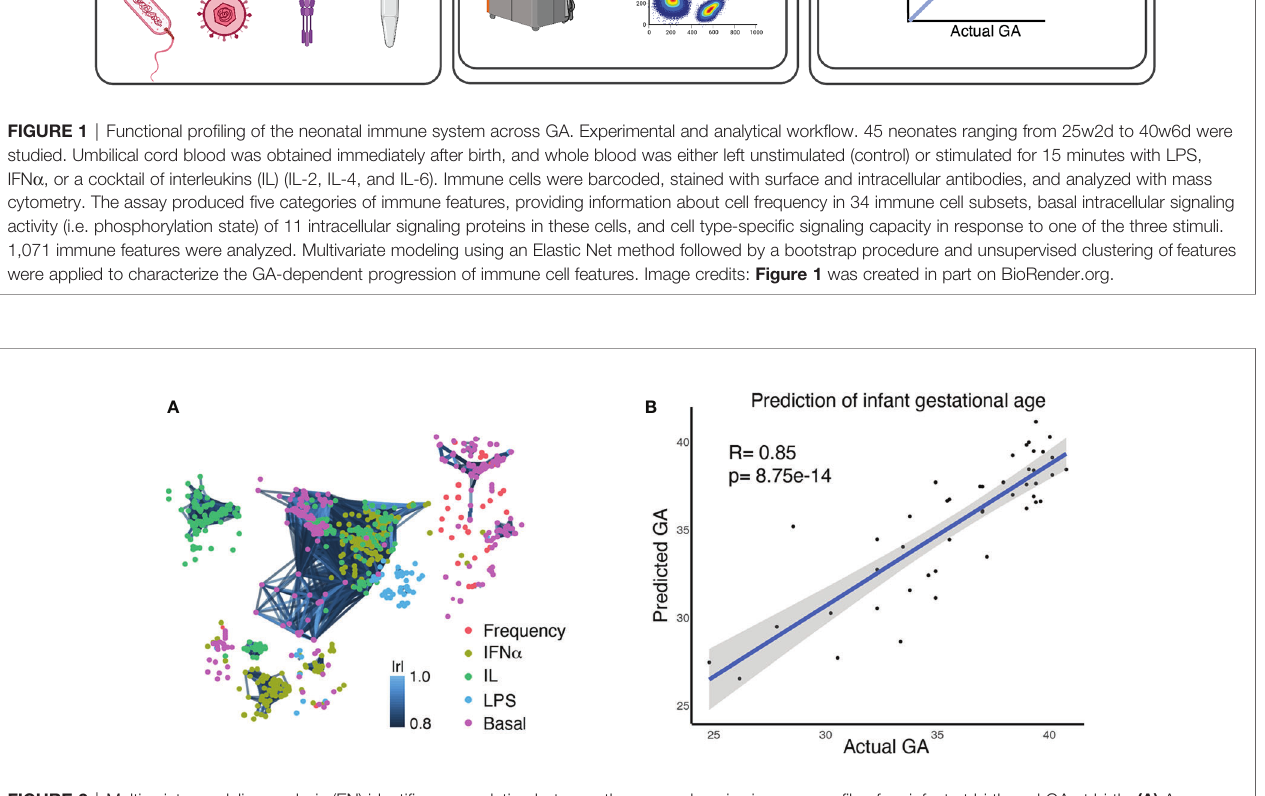
FIGURE 2 | Multivariate modeling analysis (EN) identi fi es a correlation between the comprehensive immune pro fi le of an infant at birth and GA at birth. (A) A correlation network of 1,071 immune features, representing the comprehensive immune pro fi le at birth. Each node is an immune feature, consisting of the frequency of an immune cell subset, its baseline signaling activity, or its signaling response to stimulation. Colors indicate the category of immune feature (frequency, basal signaling, or evoked signaling response to IFN a , LPS, or IL). Lines are drawn between features with a correlation coef fi cient >0.8 (Pearson ’ s) (B) An Elastic Net analysis created a model that could predict GA based on an infant ’ s comprehensive immune pro fi le at birth, con fi rming the close relationship between GA and the immune system.